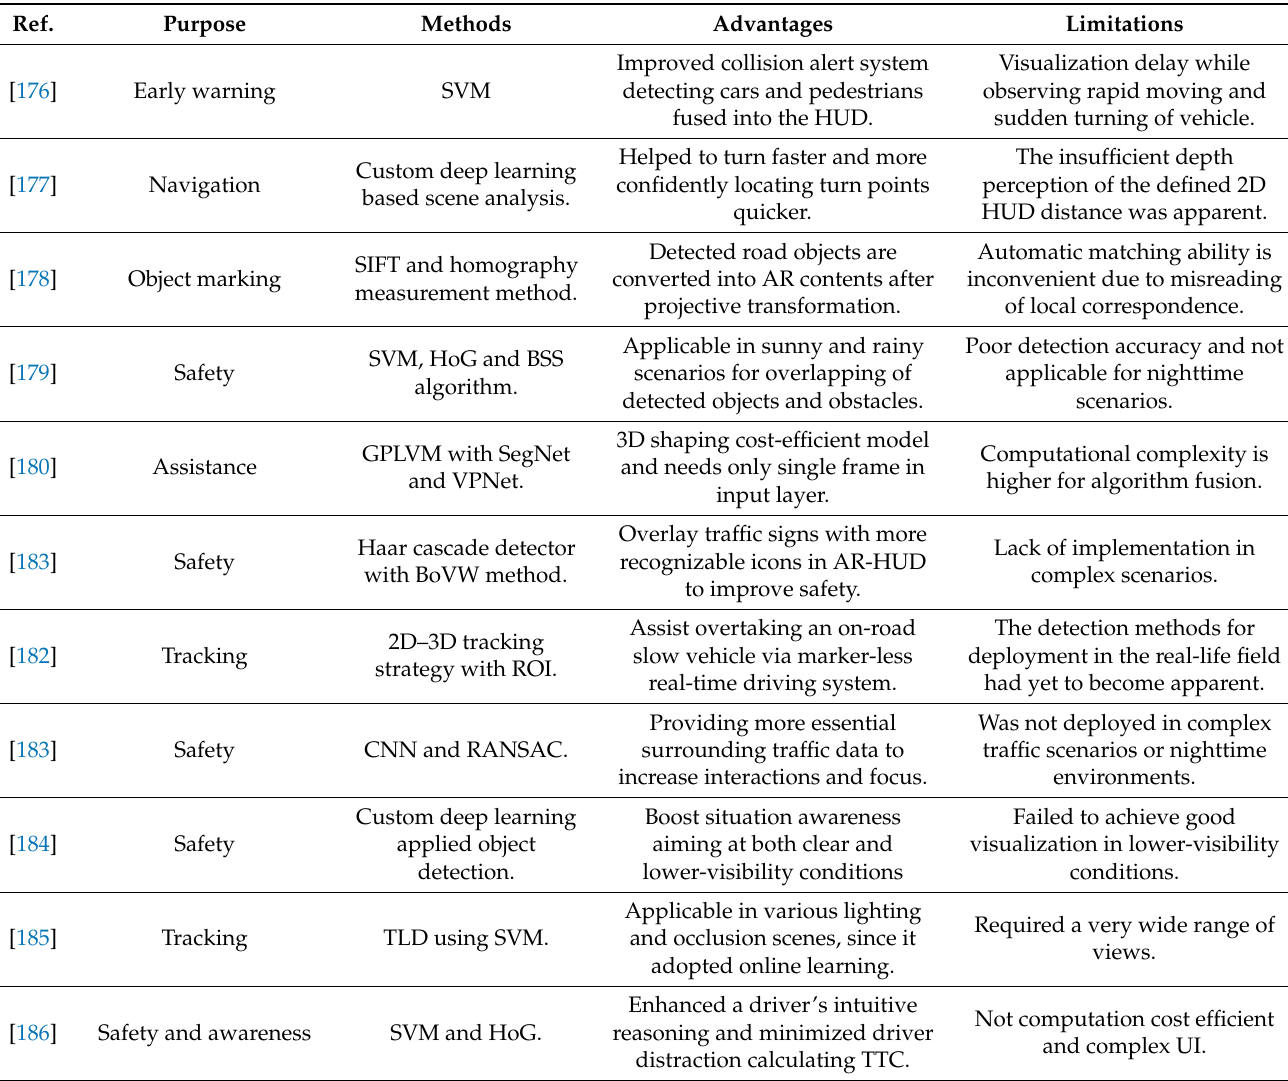
Table 13. Summary of multiple deep learning methods for